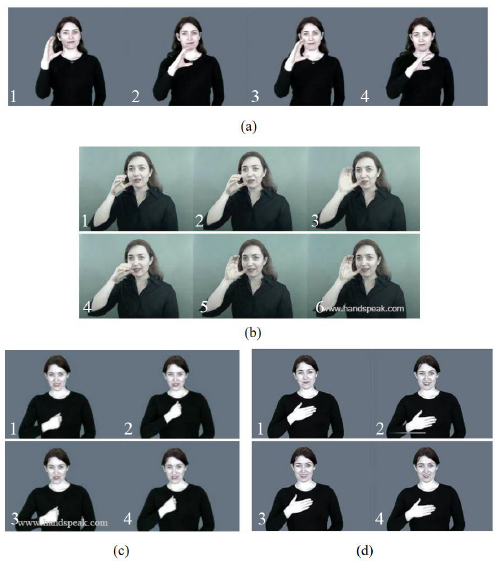
Figure 3. A series of images to illustrate the gestures that formed the ASL words ( a ) “search”, ( b ) “drink”, ( c ) “sorry”, and ( d ) “please” [27].